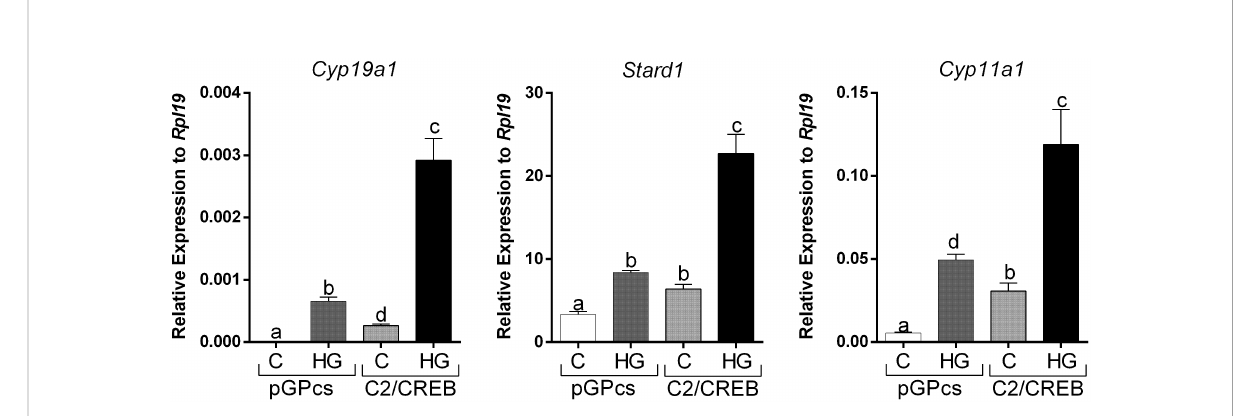
FIGURE 7 SIK inhibition enhances C2/CREB stimulation of gene expression. Rat GCs were infected 2 h after plating with lentivirus carrying an empty plasmid (pGPcs) or C2/CREB. 24 h later, cells were treated with vehicle or HG (0.5 µM). Cyp19a1 , Stard1 , and Cyp11a1 mRNA levels were determined 48 h after adding HG. One-way ANOVA followed by Tukey. Columns labeled with different letters differ signi fi cantly a-b, a-d, and b- d, p < 0.05; a-c, and b-c p < 0.01, n =